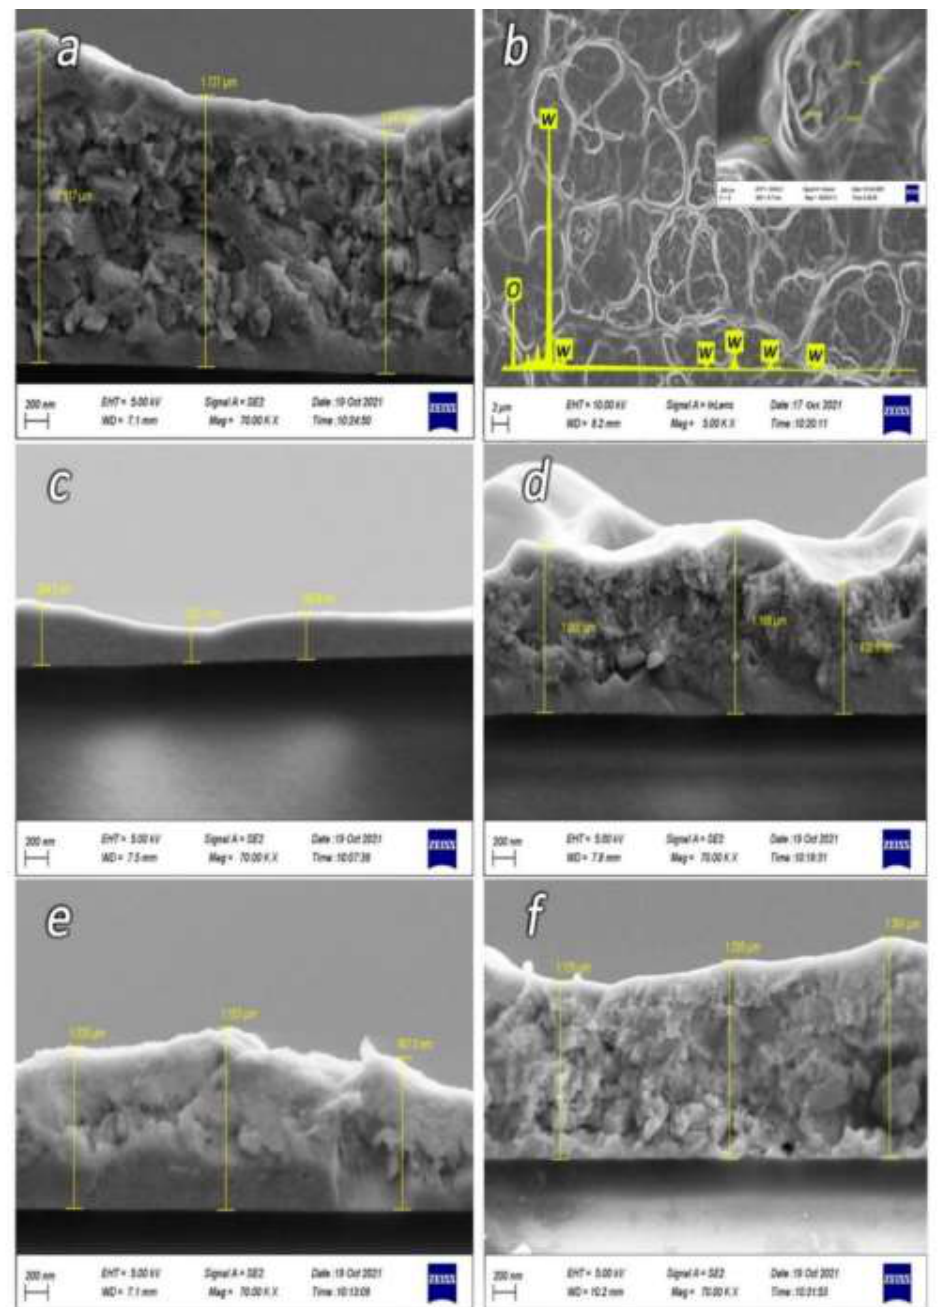
Figure 4: (a) shown FE-SEM, (b, d, e, f, g) cross-section, and (c) EDX of WO 3 thin film at substrate temperature 350 ͦ C, and optimal concentration of